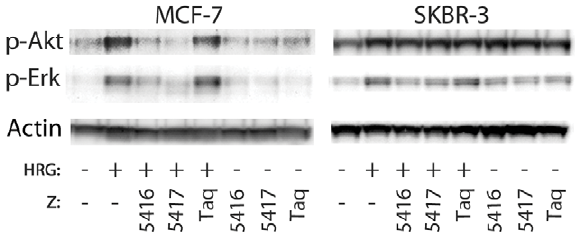
Figure 5. Western blot analysis of phosphorylated Akt and Erk upon addition of heregulin and/or HER3-specific Affibody molecules. Phospho-Akt and phospho-Erk detected by western blot of cell lysates from MCF-7 and SKBR-3 cells treated with ( + ) or without ( 2 ) 0.05 nM heregulin (HRG) and 100 nM Affibody molecules (Z). As a control, b -actin was detected to show that the protein concentrations of the different lysates were equivalent.